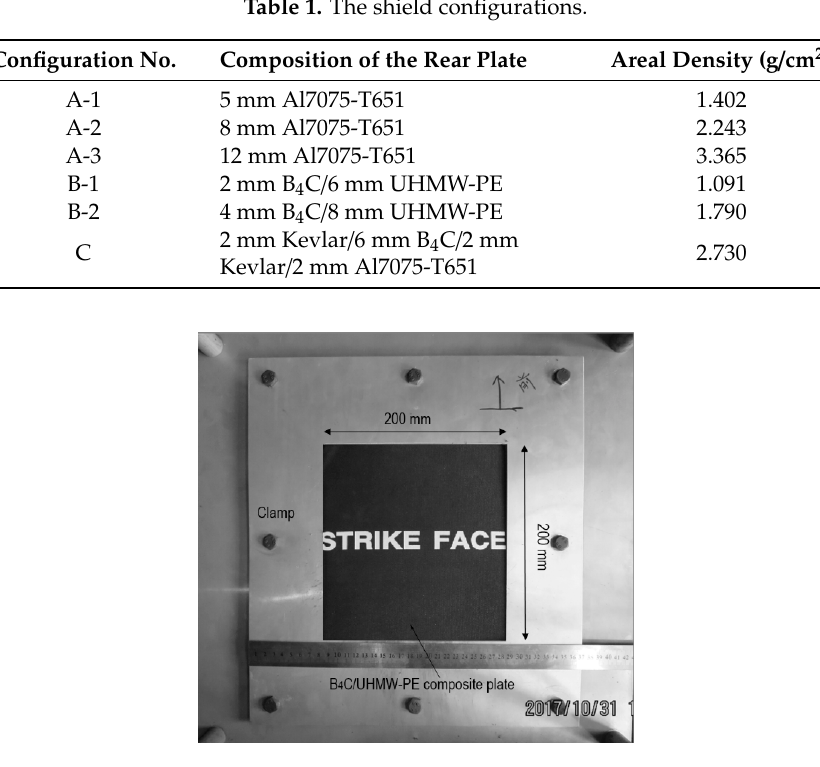
Figure 2. Fixed B 4 C/UHMW-PE composite plate.